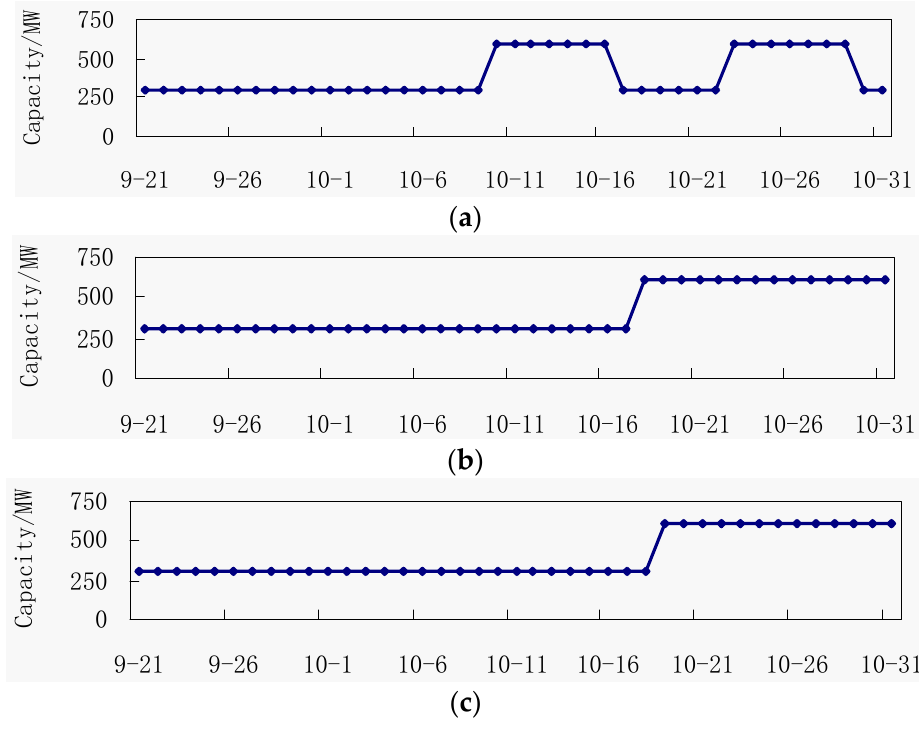
Figure 8. Boot capacity of Plant F for three methods: ( a ) POA; ( b ) first adjustment; ( c ) IPOA. The calculation results on the YNPG are shown in Table 2. IPOA is compared with heuristics